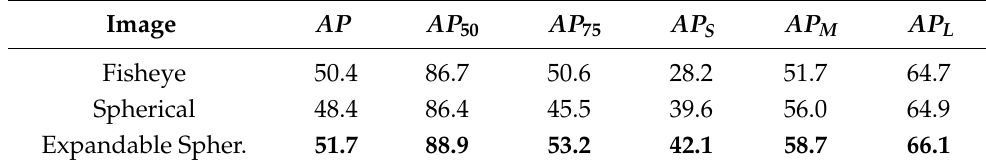
Table 14. Accuracy of different projections of SCat model on the